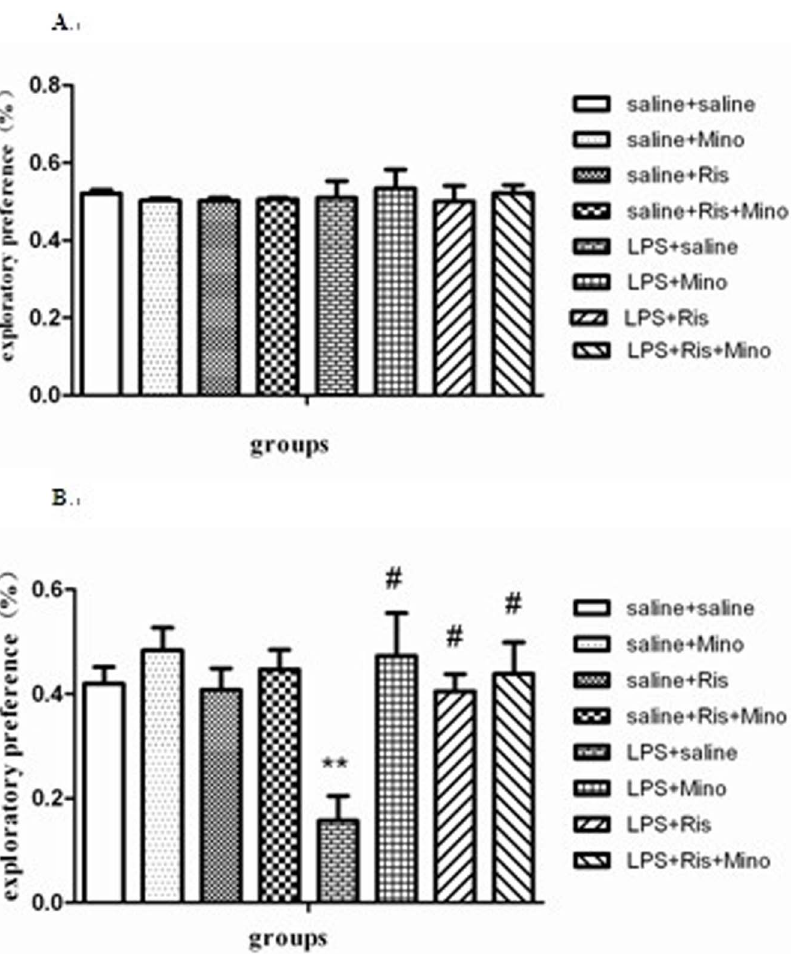
Figure 4. Effects of minocycline, risperidone and combination of these two on LPS-induced non-spatial memory deficits in rats (the training session as shown in Figure 4A and the retention session as shown in Figure 4B). The data is shown as means 6 SEM. n=8 for each group. ** P , 0.01, compared with saline-injected group; # P , 0.01, compared with LPS-injected group. cortex, thalamus and hippocampus (Figure 6E). Intragastric PPI test. Figure 5 shows the effects of minocycline, risperi- done and both of them on LPS-induced PPI deficits in rats. The application of minocycline, risperidone or both of them had no main effects of group treatment [F(1,7) = 22.353, P , 0.001] and effect on Iba1- immunoreactivity in the saline-injected rats (Figure 6B–D), but it markedly reduced number of Iba1- prepulse intensities [F(1,7) =92.538, P , 0.001] were significant. immunopositive cells in the LPS-injected rats (Figure 6F–H). We Subsequent ANOVA analysis revealed significant differences (all counted number of Iba1-immunopositive cells in the VH, Cx, and P , 0.001) in all dB groups (75, 80, 85 dB). A posteriori analysis Th for statistical comparison. Two-way ANOVA analysis revealed indicated a significant difference (P , 0.01) between saline- and statistical difference in the main effect of LPS [(VH: F =1.121, LPS-injected rats. Furthermore, a posteriori analysis demonstrated P , 0.001; Cx: F = 287.860, P , 0.001); Th: F= 1.220, P , 0.001)]; that minocycline, risperidone and both of the two attenuated in the main effect of treatment[(VH: F = 287.810.121, P , 0.001; significantly (all P , 0.001) PPI deficits in rats received the neonatal Cx: F= 1.243, P , 0.001); Th: F = 287.860.220, P , 0.001)]; and hippocampal injection of LPS. The data suggest that the neonatal intrahippocampal LPS injection affects adult sensorimotor gating performance, and minocycline and risperidone are able to rescue the defective sensorimotor gating.